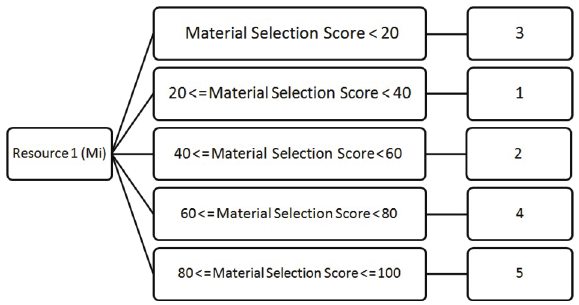
Fig. 5. IF-THEN rules for material